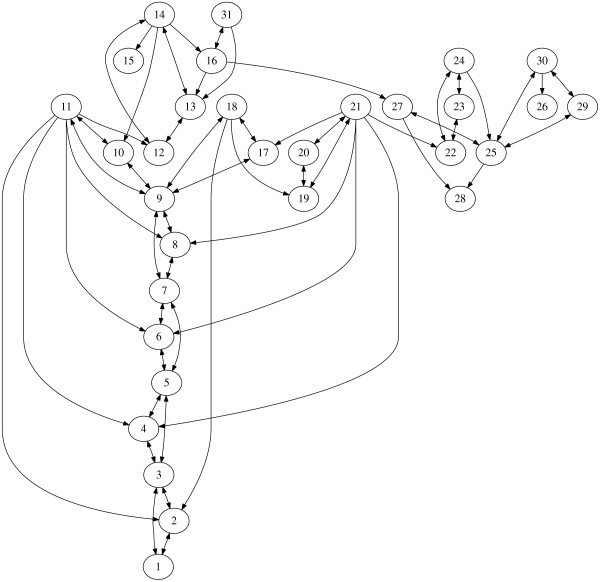
The TNFα model. Network representation of the Survival and apoptotic pathways initiated by TNF-α.